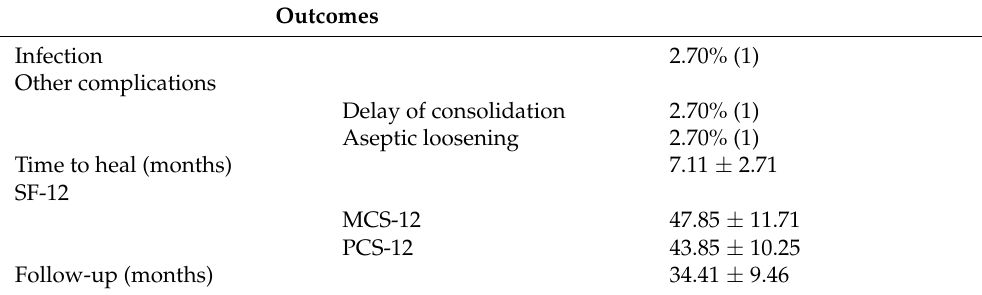
Table 4. Outcomes. SF-12: 12-item short-form survey; MCS-12: mental component score; PCS-12: physical component